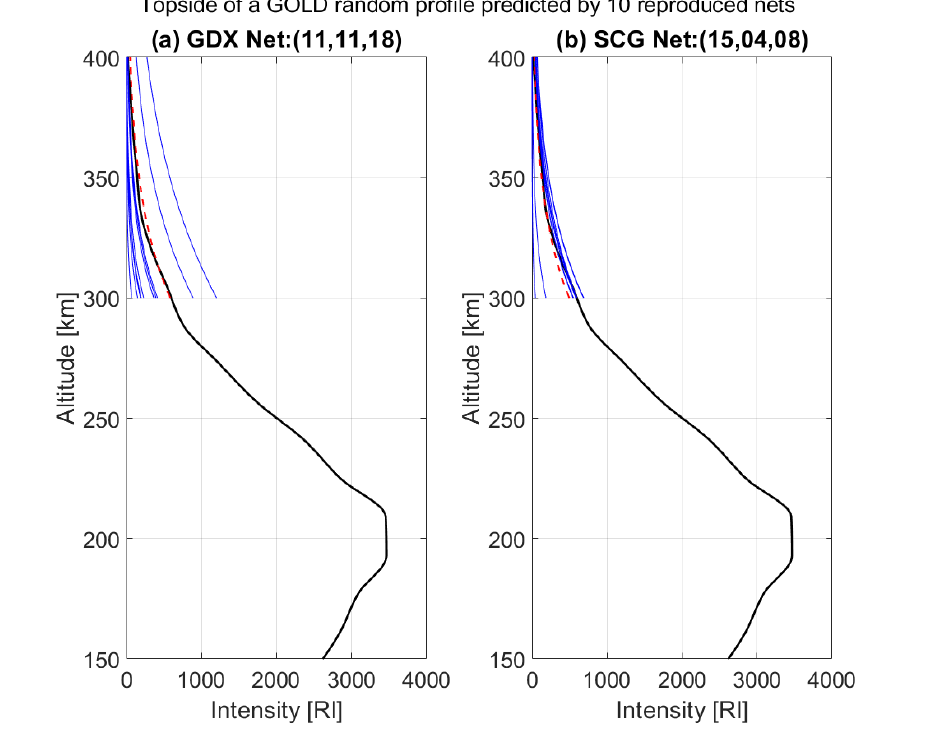
Figure 12. A random GOLD 135.6 nm intensity profile test to verify the performance of the reproduced 10 nets ( a ) trained with GDX and HDLs as 11:11:18, and ( b ) trained with SCG and HDLs as 15:4:8. The vertical and horizontal axes indicate the tangent altitude and geographic latitude ( ◦ N), respectively. The training of all reproduced nets was under the same initial setup for each. The black solid line indicates the GOLD data; the red dashed lines indicate the original nets trained from 8000 loops; the blue lines indicate the predicted topside by ten reproduced nets of